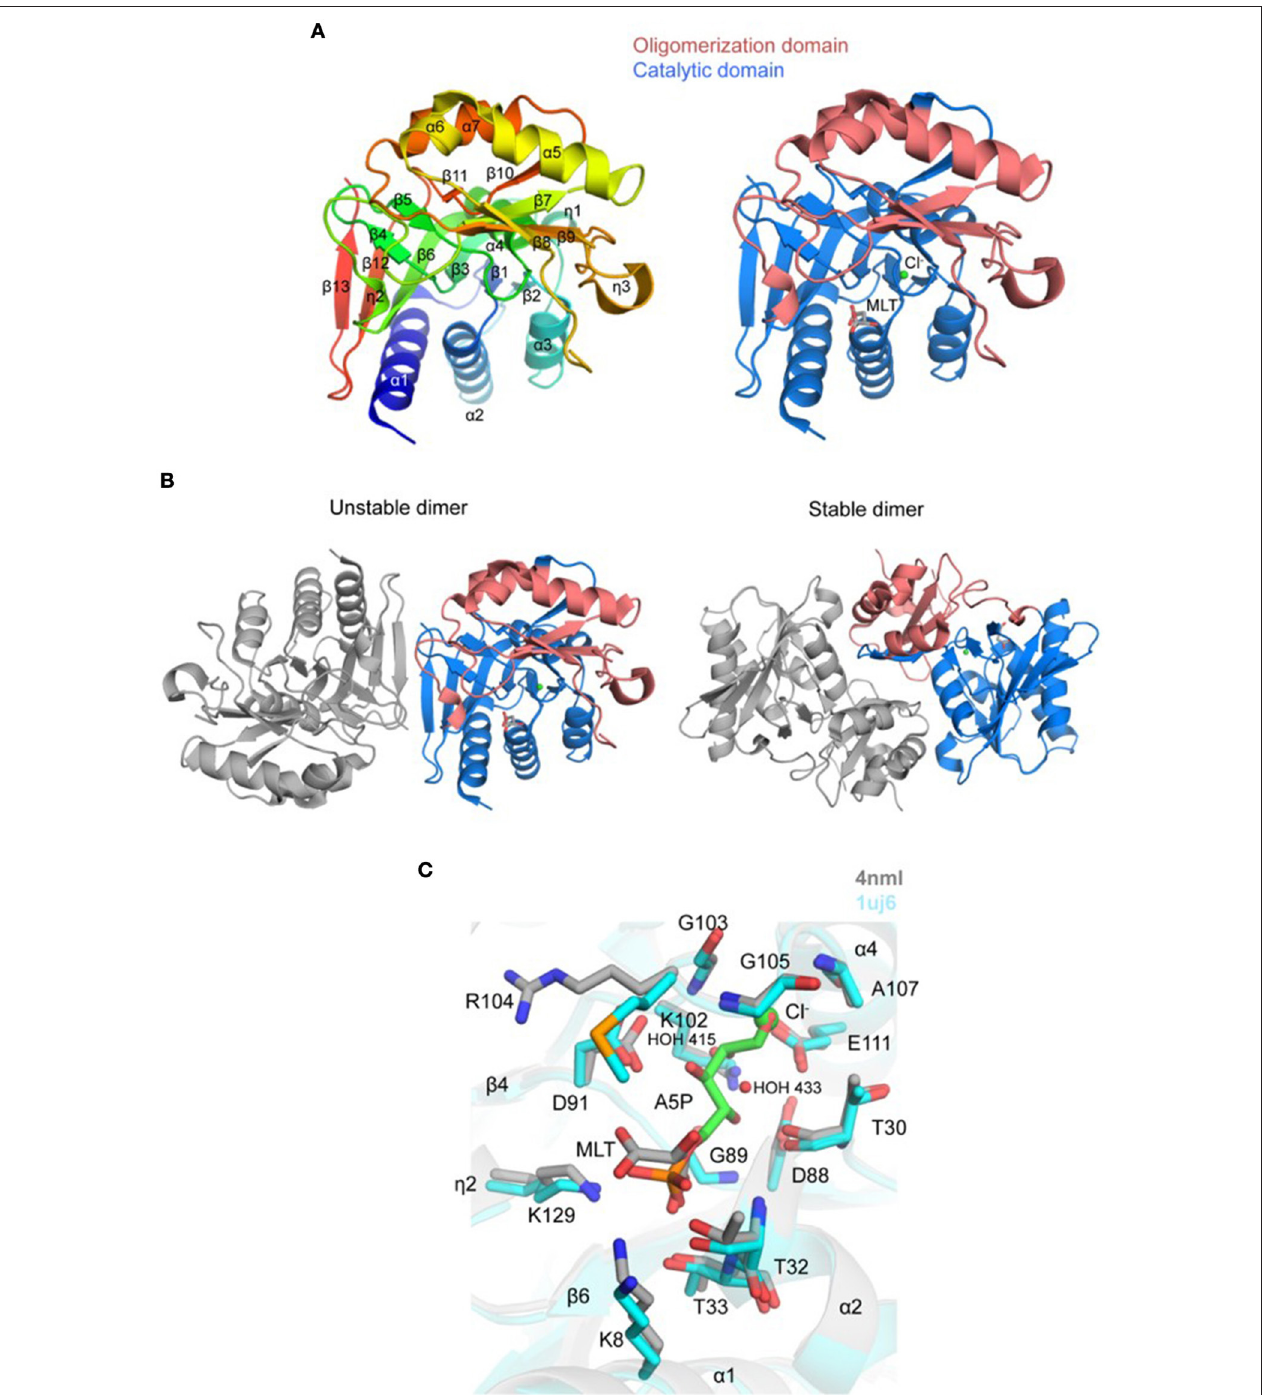
FIGURE 5 | Crystal structure of Tg RPI (A) . Ribbon representation of Tg RPI monomer (left side) colored blue (N-terminus) to red (C-terminus). Catalytic domain and oligomerization domain of Tg RPI with bound D-malate (MLT; sticks) and chloride ion (Cl − ; green sphere) are shown on the right. (B) . Unstable and stable Tg RPI dimers according to PISA prediction (C) . Pairwise structural alignment of Tg RPI (gray; MLT is shown in sticks and Cl − as green sphere) and Tt RPI (cyan ribbon) with bound arabinose 5-phosphate (A5P; sticks) showing active site with residues of Tg RPI are shown in sticks and labeled in one-letter code. Equivalent residues of Tt RPI are displayed. Water molecules are shown as small red